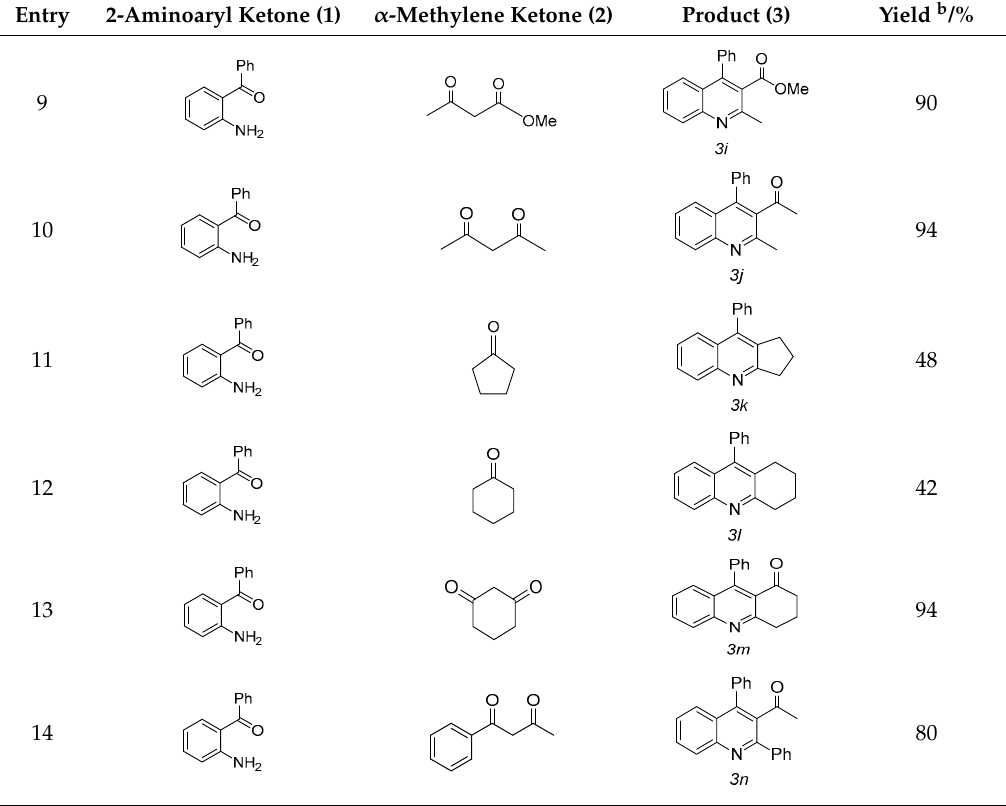
a Reaction conditions: 2-aminoaryl ketones (0.3 mmol), α -methylene ketone (0.36 mmol),